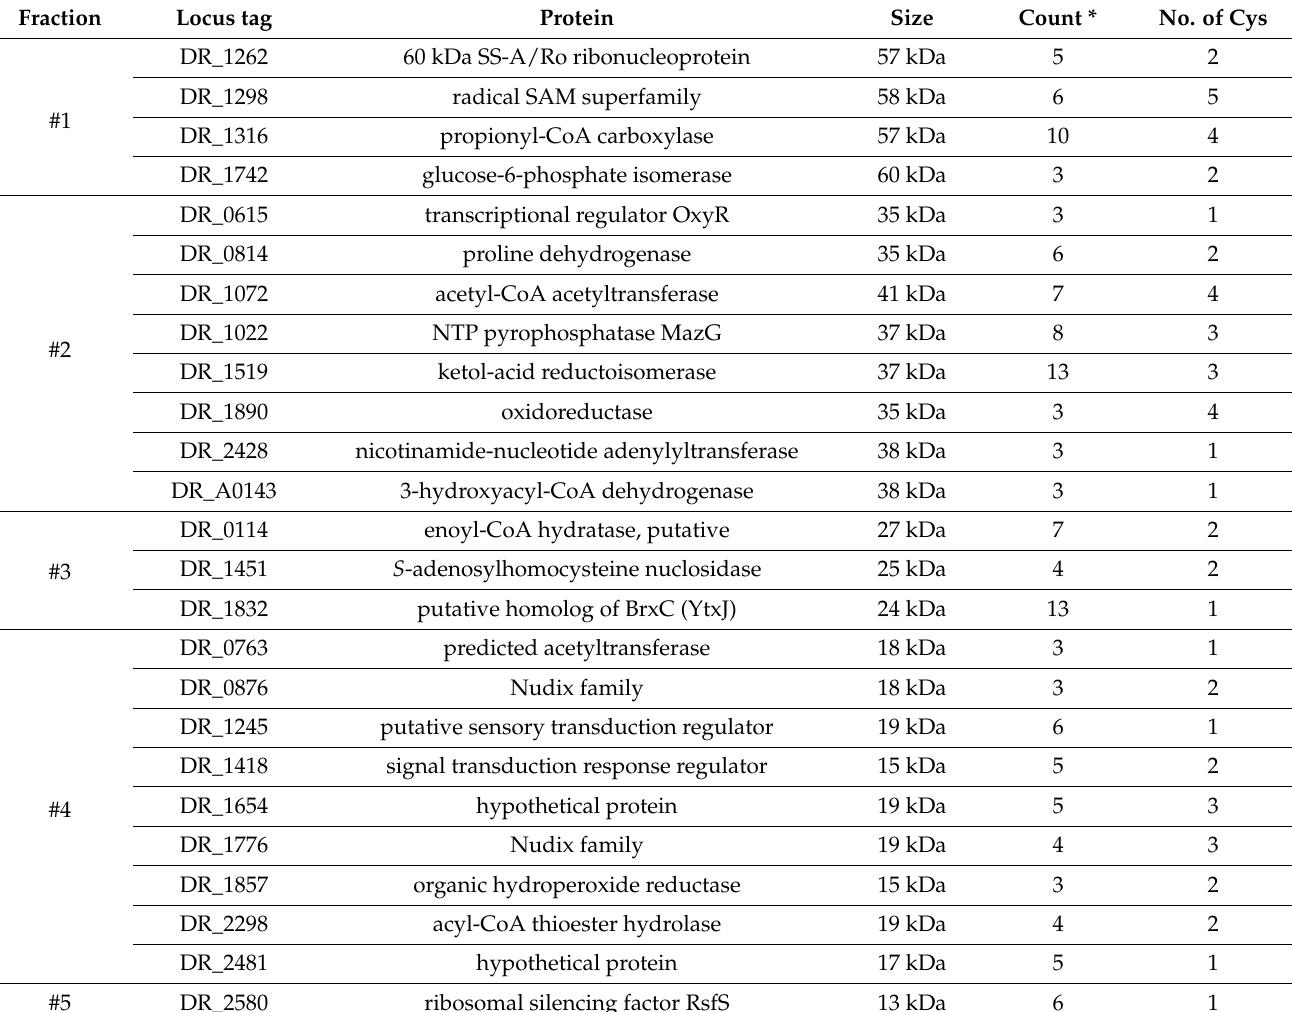
Table 1. Potential AbxC interacting